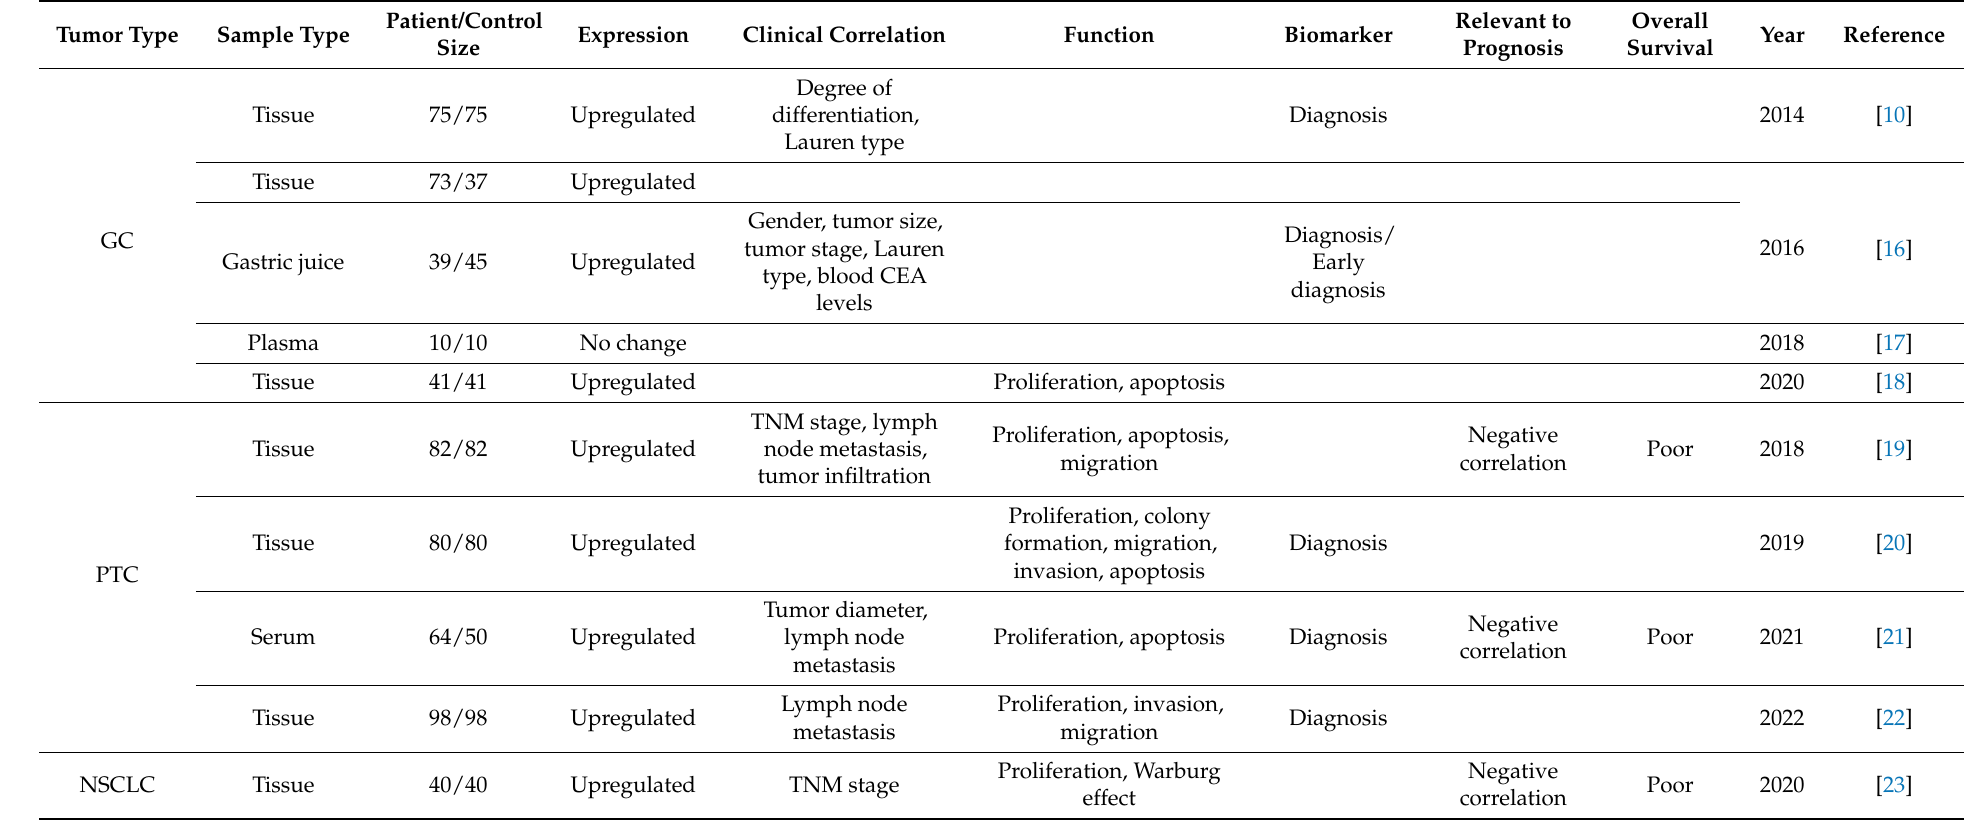
Table 1. Summary of studies describing oncogenic role of ABHD11-AS1 lncRNA in different